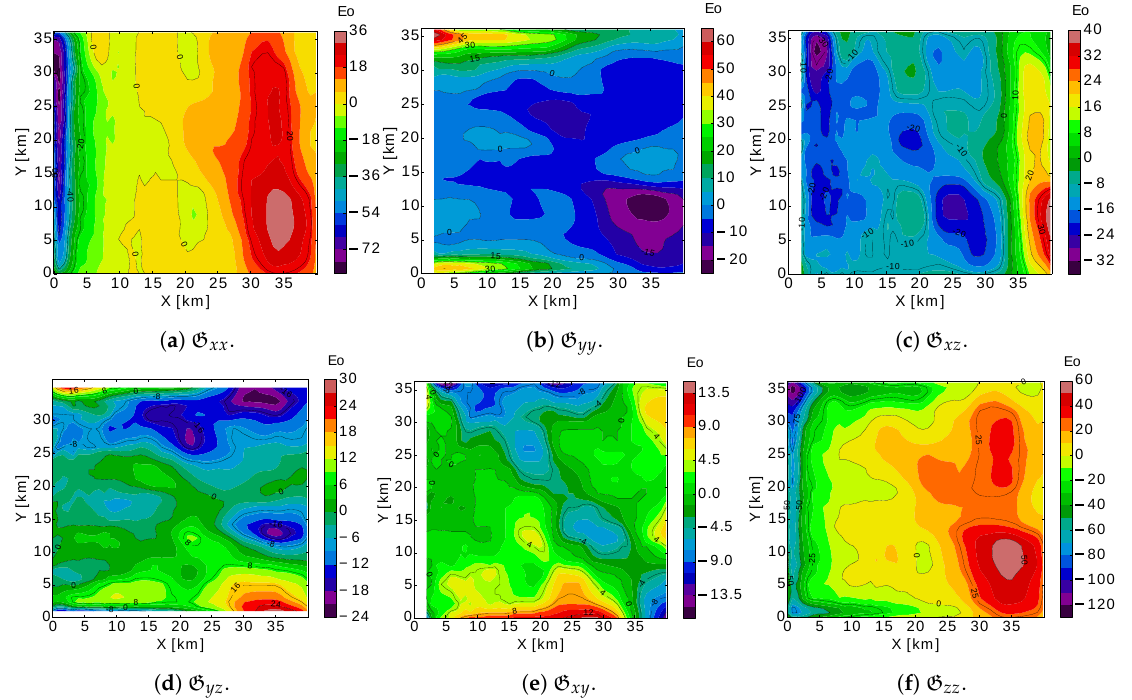
Figure 10. Air-free gradiometric response for the real data-based model.